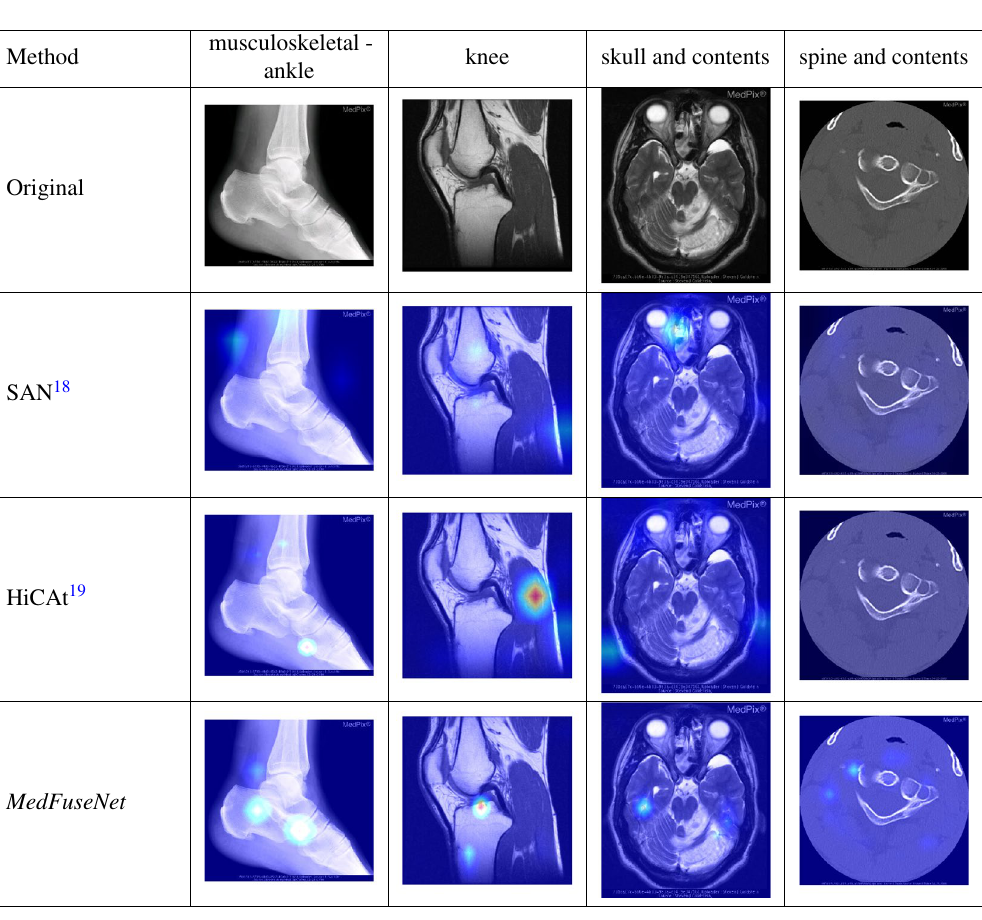
Table 9. Image Attention visualization for SAN, Hie. Co-Att, and MedFuseNet